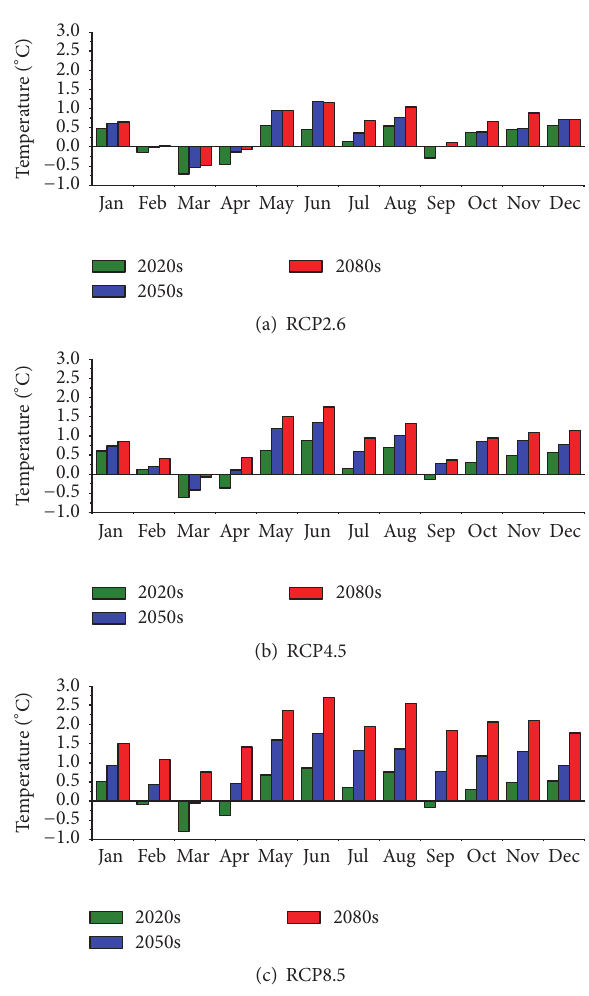
Figure 4: Mean monthly changes in projected temperature with respect to the base period under three scenarios.